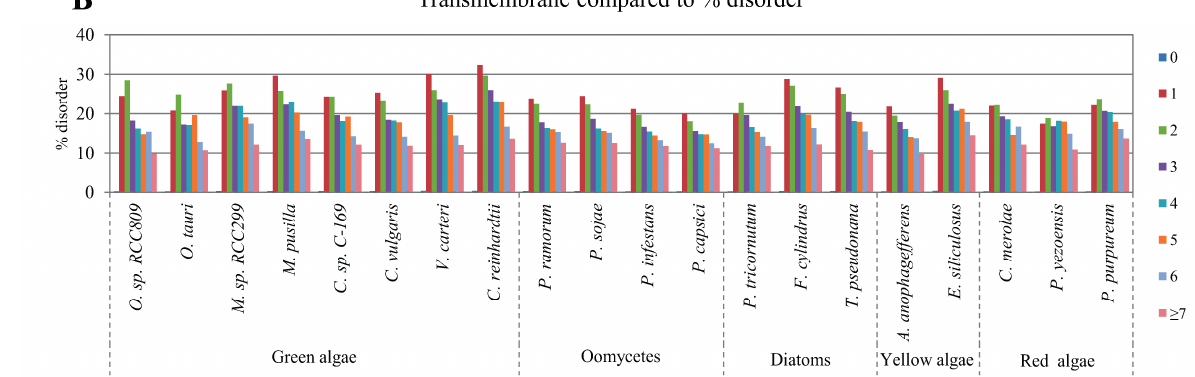
Figure 5. Correlation between disordered protein content and transmembrane regions.